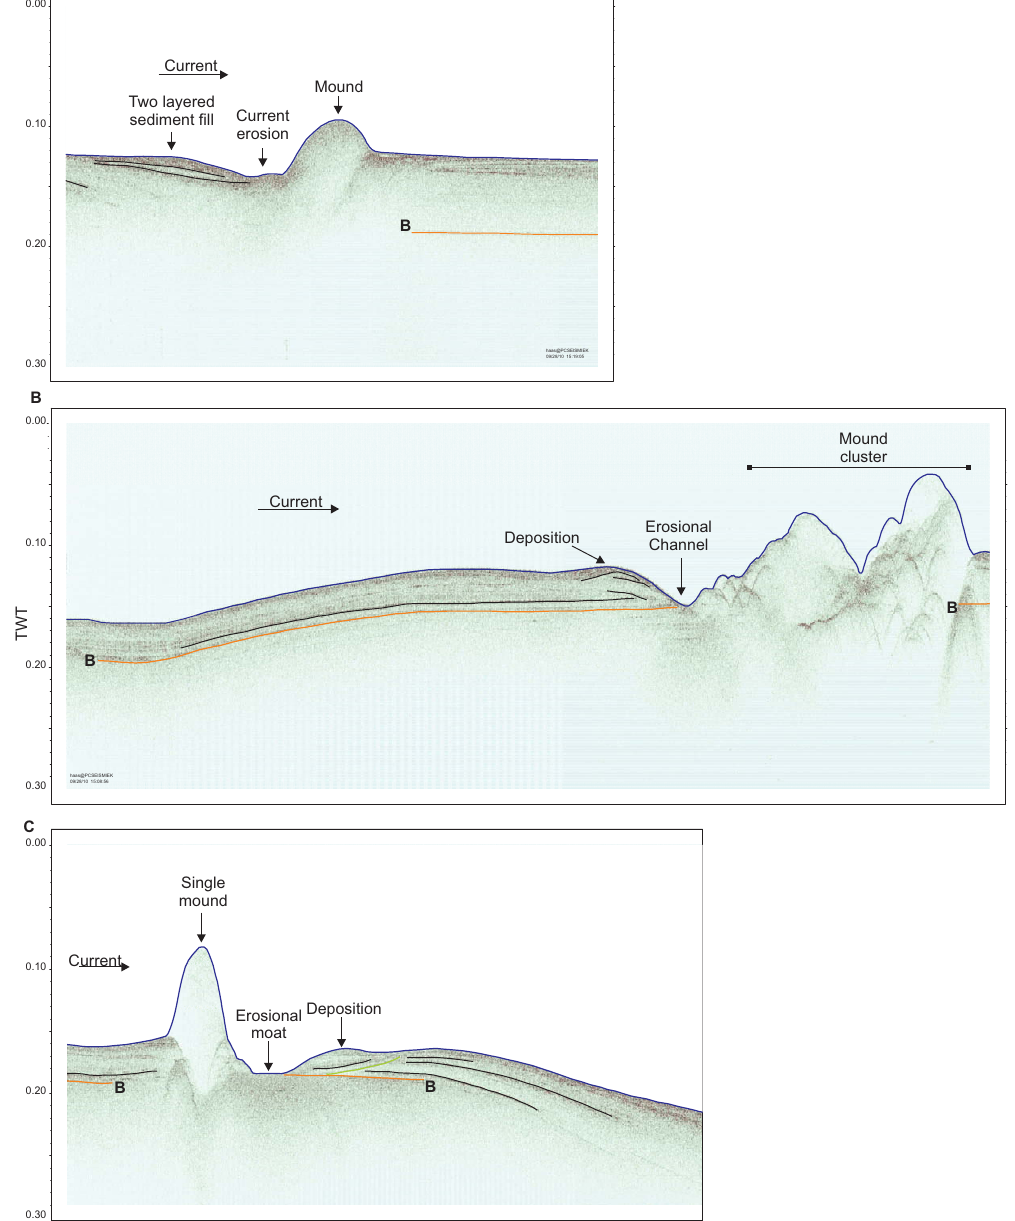
Figure 4 Fig. 4. 3.5kHz lines (positions of lines are shown in Fig. 1) recorded in a SW–NE direction (A–C) , showing the different mound types in the upper, mid and deep part of the Cape Lookout CWC area. (A) Single mound at the upper slope. (B) Multi-summited mounds in the mid slope area. (C) Single mound in the deep area. Underneath the mounds a strong reflector was observed that forms the basement of the mounds (orange